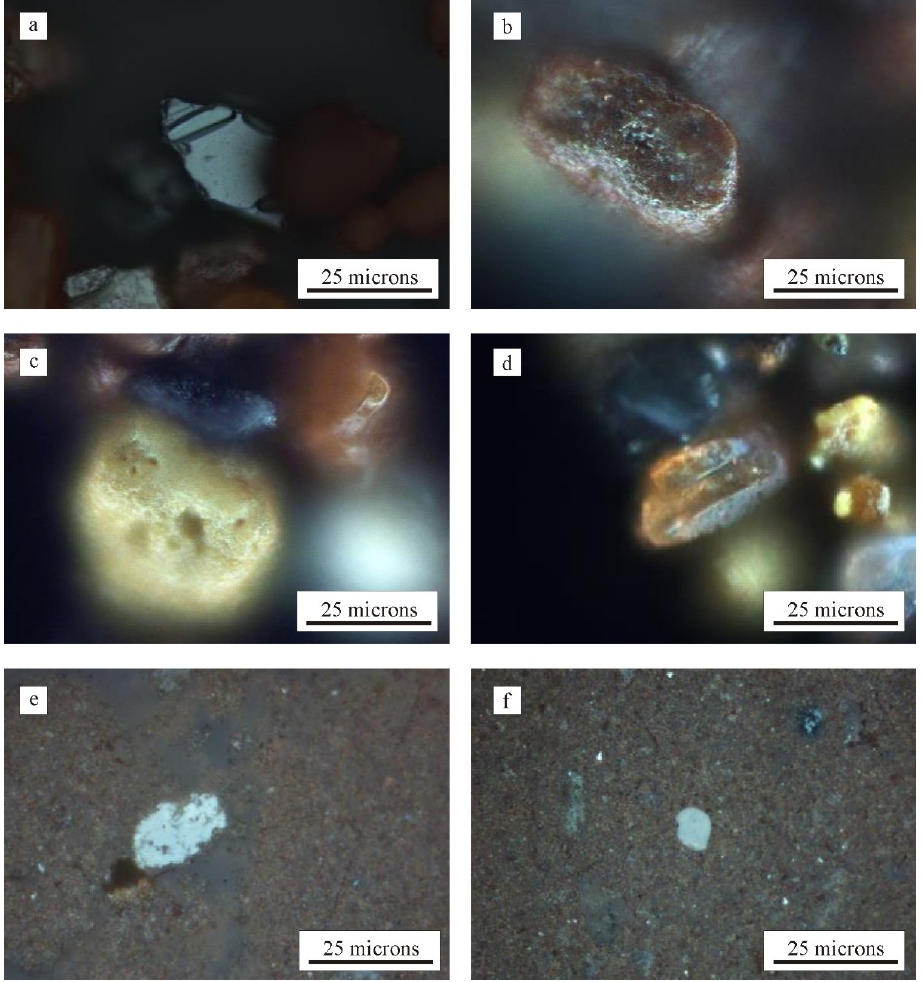
Figure 2. Typical mineral grains of the studied red mud. ( a ) ilmenite (coarse grain fraction) ( b ) hematite (coarse grain fraction), ( c ) goethite (coarse grain fraction), ( d ) gibbsite (coarse grain fraction), ( e ) anatase in the matrix, ( f ) zircon in the matrix.